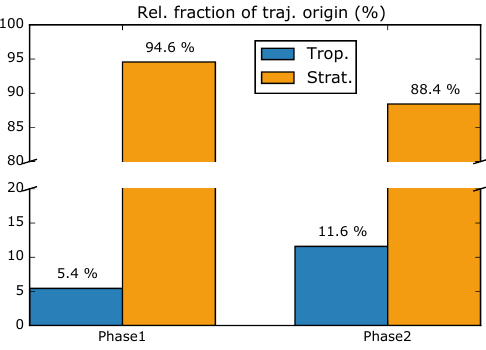
Figure 7. Fraction of trajectories with tropospheric (blue) or strato- spheric (orange) origins for each